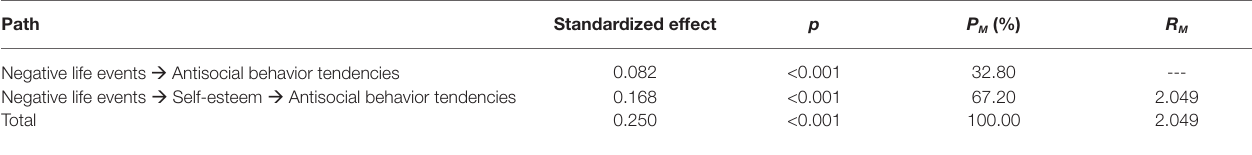
FIGURE 2 | The mediation model of negative life events, self-esteem, and antisocial behavior tendencies. (The standardized direct effects and 95% CI between variables are presented here. Paths of the control variables are omitted for TABLE 2 | The mediation effect size of self-esteem in the relationship between negative life events and antisocial behavior tendencies. Path